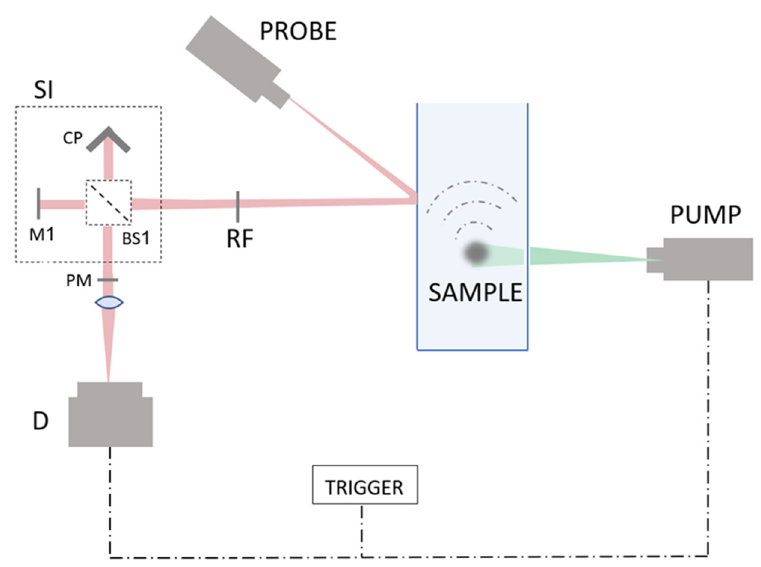
Figure 1. The system. The PUMP is the photoacoustic excitation laser relevant only for the photoacoustic part of the manuscript. The detection system consists of all the components on the right side of the sample. A PROBE laser illuminates the vibrating object. The reflected speckle pattern is diffused by a rotating diffuser RF, moving forward to a shearing interferometer SI, containing a corner prism CP, a mirror M1, and a beam splitter BS1. Then, the generated spectrum passes through a phase plate PM which retards central low frequency by 𝜋 and thus, creates subtraction of the low frequencies from the high frequencies. The two channels are focused onto the detector D.